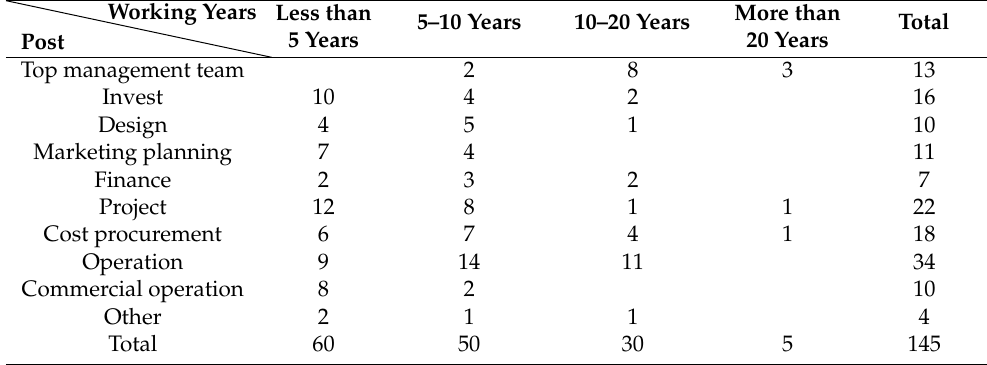
Table 3. Contingency table of respondents’ positions and years of real estate experience.